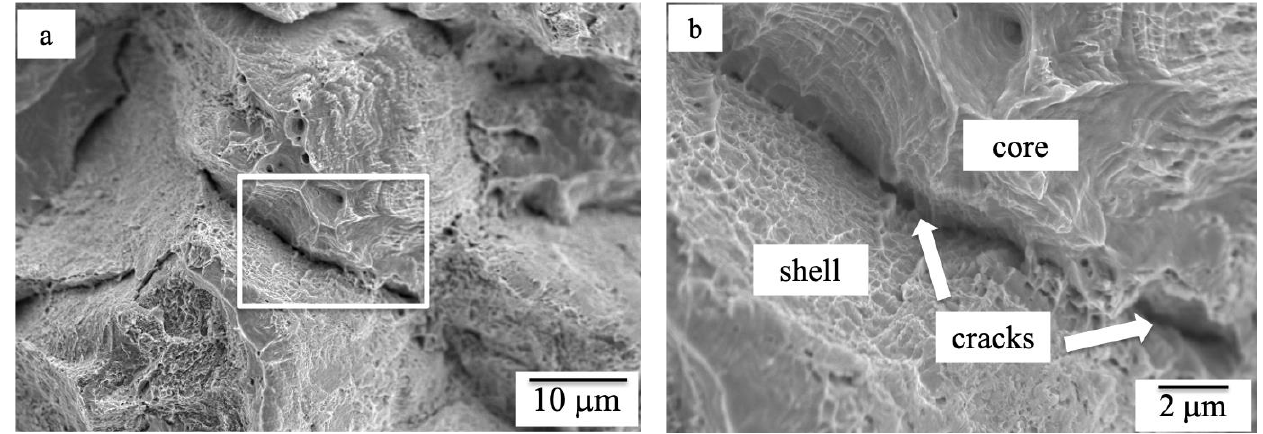
Figure 6. SEM micrograph of fracture surface of HS pure Cu after tensile testing: ( a ) low magnification and ( b ) enlarge of rectangular in ( a ).